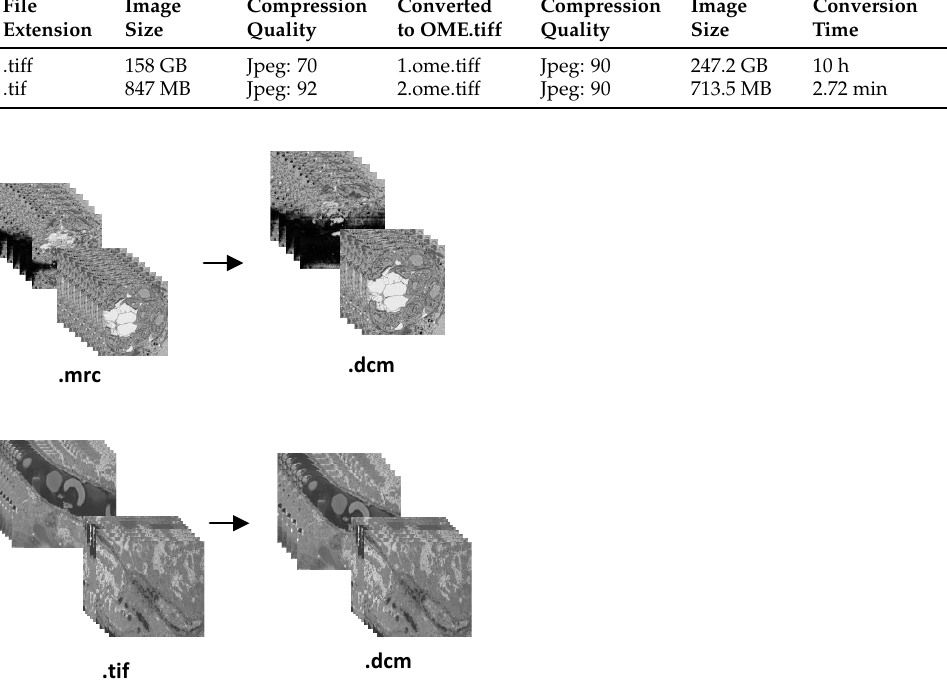
Figure 10. Two distinct (.mrc and .tif) FIB-SEM microscope images were successfully converted into standard